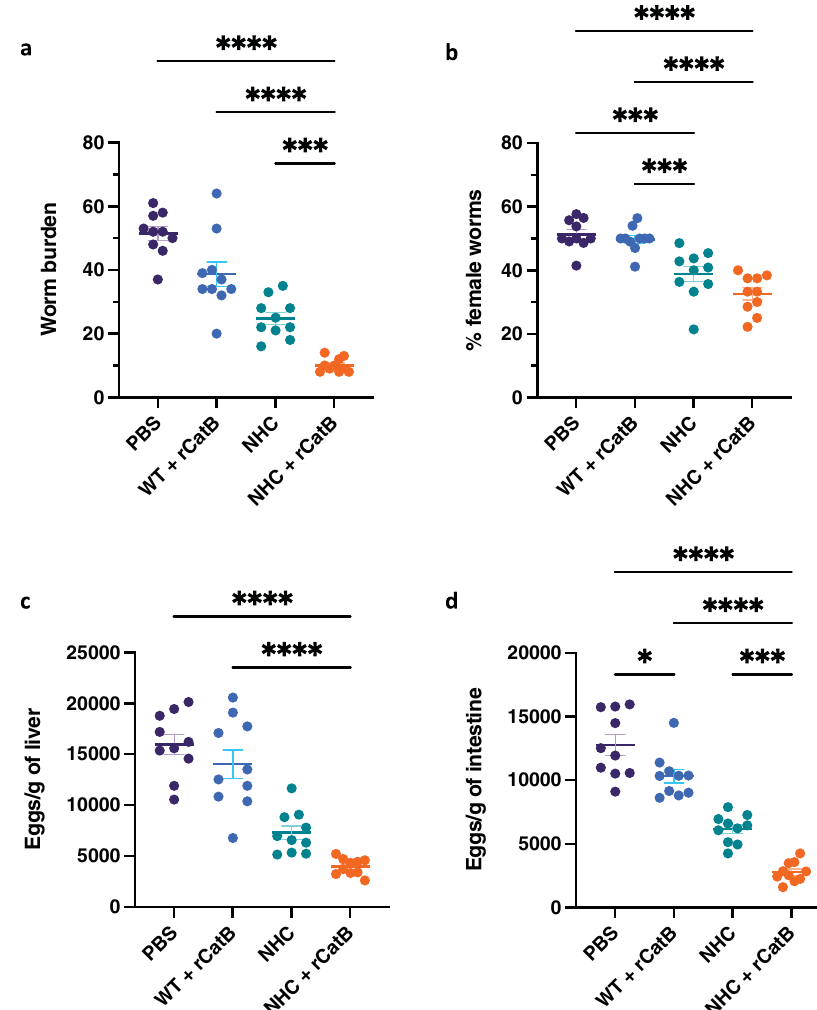
Fig. 4 Parasite burden. The worm burden ( a ) and the percentage of female worms ( b ) were assessed 7 weeks post-challenge per individual mouse in each group. Egg loads were expressed per gram of liver ( c ) and intestine ( d ) for each group. Each independent experiment consisted of fi ve animals per group. Each experiment was performed twice. Data were shown as mean ± SEM. Statistical signi fi cance was determined by one-way ANOVA with Tukey ’ s multiple comparisons (* P < 0.05, *** P < 0.001, and **** P <